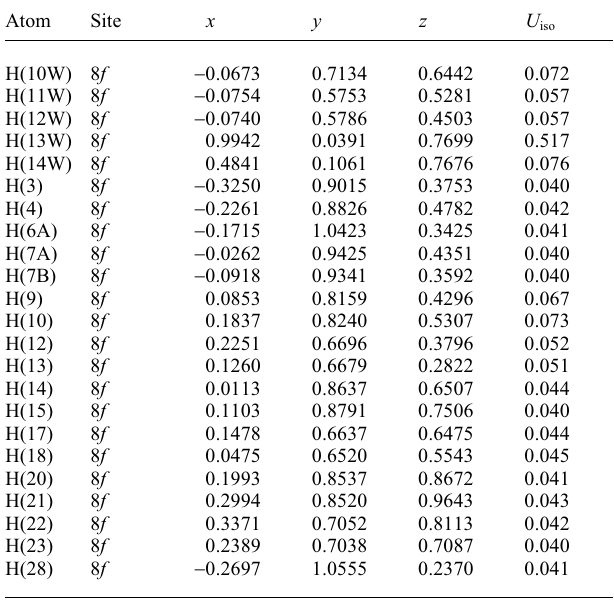
Table 1. Data collection and